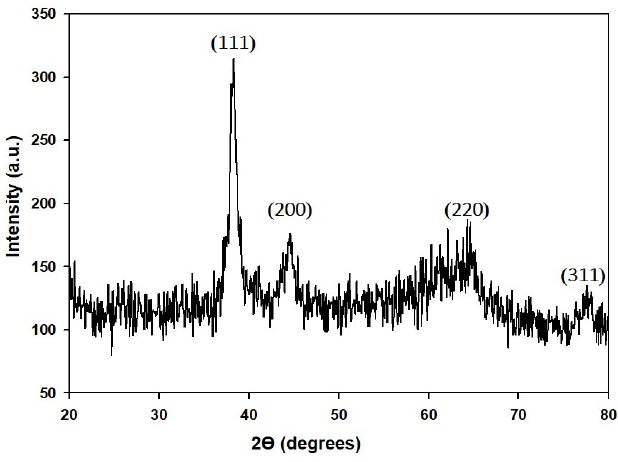
Figure 5. XRD analysis of GP-AuNPs .